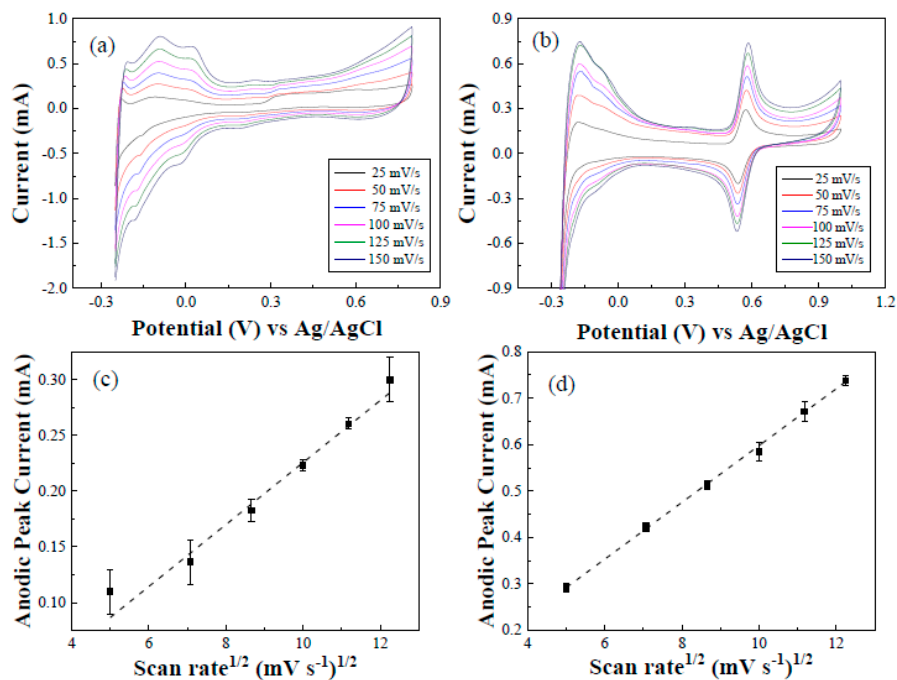
Figure 11. Cyclic voltammograms for the Pt-Mo/C/GCE in 0.5 M HClO 4 solution for scan rates of 25, 50, 75, 100, 125, and 150 mV s − 1 in the presence of ( a ) 15 mM AA; and ( b ) 10 mM DA and anodic peak current versus the square root of the potential scan rate in the presence of ( c ) 15 mM AA; and ( d ) 10 mM DA.